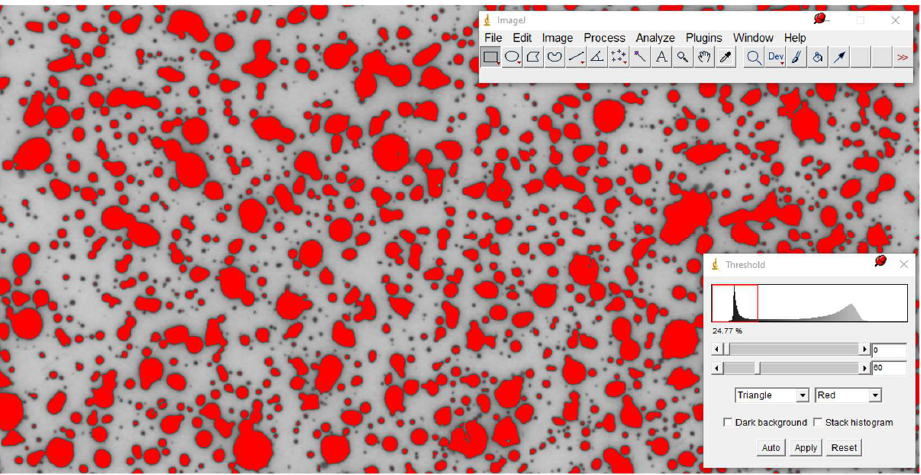
Figure 6. Example of a WSP image processed with ImageJ software. Overlap between stains must be properly managed during drop size measurement.